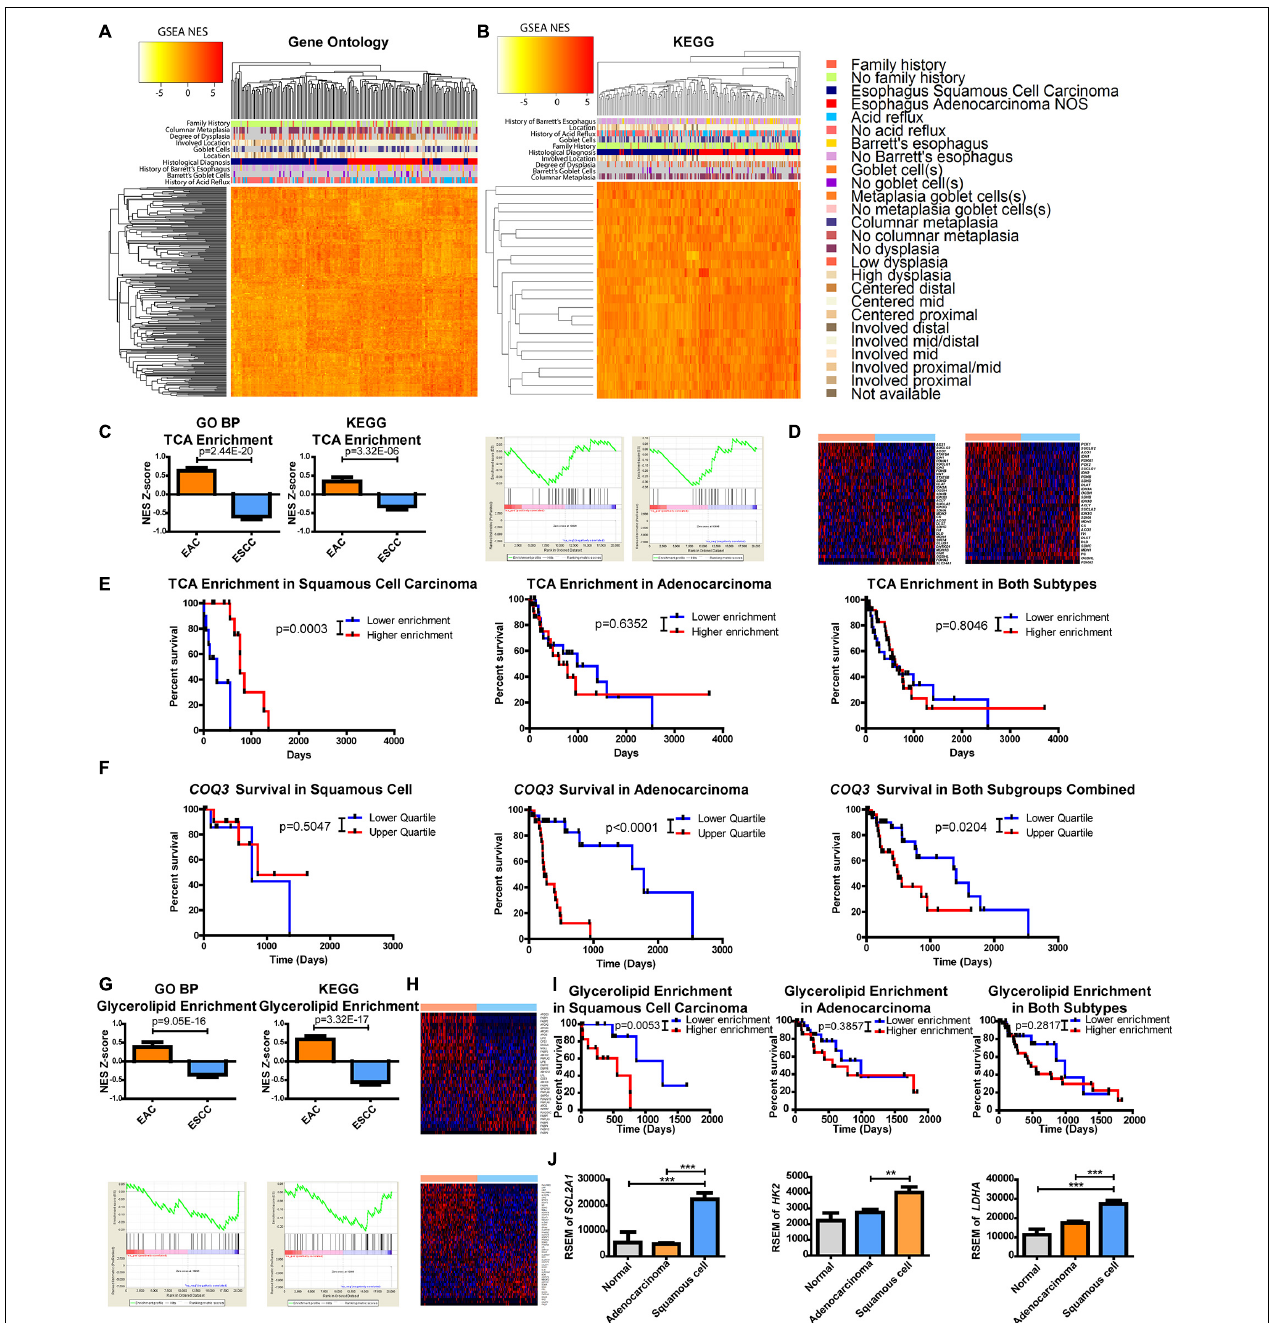
FIGURE 3 | Metabolic pathways are altered between esophageal squamous cell carcinoma (ESCC) and esophageal adenocarcinoma (EAC). Gene set enrichment analysis (GSEA) compared each patient against the average of normal tissues. Normalized enrichment scores (NESs) were plotted and hierarchically clustered for metabolic pathways, defined as ≥ 10 minimum enzymes with a minimum of 90% of enzymes, for (A) all Gene Ontology (GO) classifications and (B) metabolic pathways within the Kyoto Encyclopedia of Genes and Genomes (KEGG). (C) Each patient’s NES (top) and group average (bottom) for the tricarboxylic acid (TCA) cycle from GO biological process (BP) (left) and KEGG (right) (D) along with the heatmaps of the comprising genes within the pathway of GO (top) and KEGG (bottom). (E) Patient survival was plotted by separating the upper and lower quartiles of TCA NES through KEGG’s pathway for ESCC (left), EAC (middle), and both (right). (F) Patient survival was plotted by separating the upper and lower quartiles of COQ3 expression in ESCC (left), EAC (middle), and both (right). (G) Each patient’s NES (top) and group average (bottom) for glycerolipid enrichment from GO BP (left) and KEGG (right) (H) with the heatmaps of the comprising genes within the pathway of GO (top) and KEGG (bottom). (I) Patient survival was plotted by separating the upper and lower quartiles of glycerolipid NES through KEGG’s signature for ESCC (left), EAC (middle), and both (right). (J) Gene expression within each subtype. Pathway enrichment significance was calculated by a Student’s t -test, Mantel–Cox log-rank for survival, and gene expression was compared with a one-way ANOVA with a Bonferroni’s multiple comparison test. ** p < 0.01, *** p < 0.001.